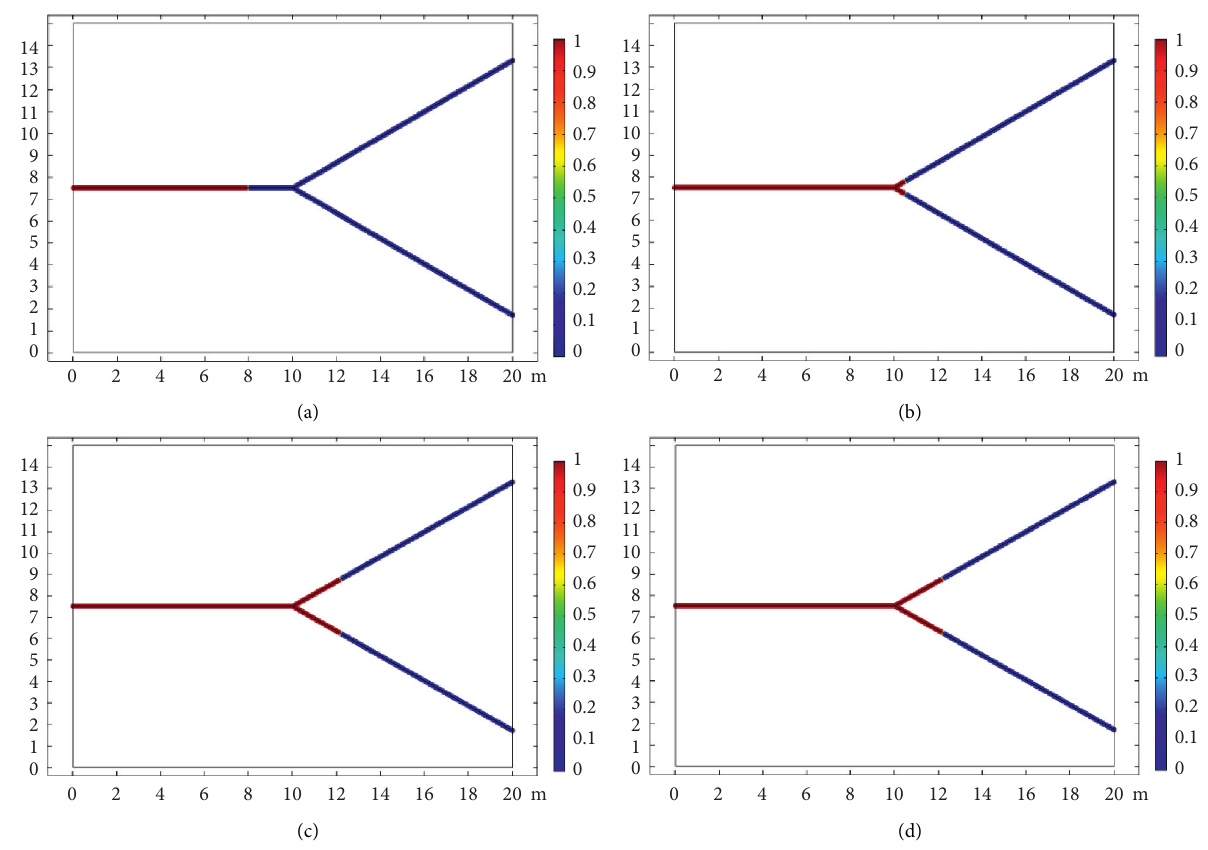
Figure 7: Relationship between diffusion range of water-displacing diffusion of slurry and grouting time. (a) t � 50 s. (b) t � 100 s. (c) t � 150s. (d) t � 200